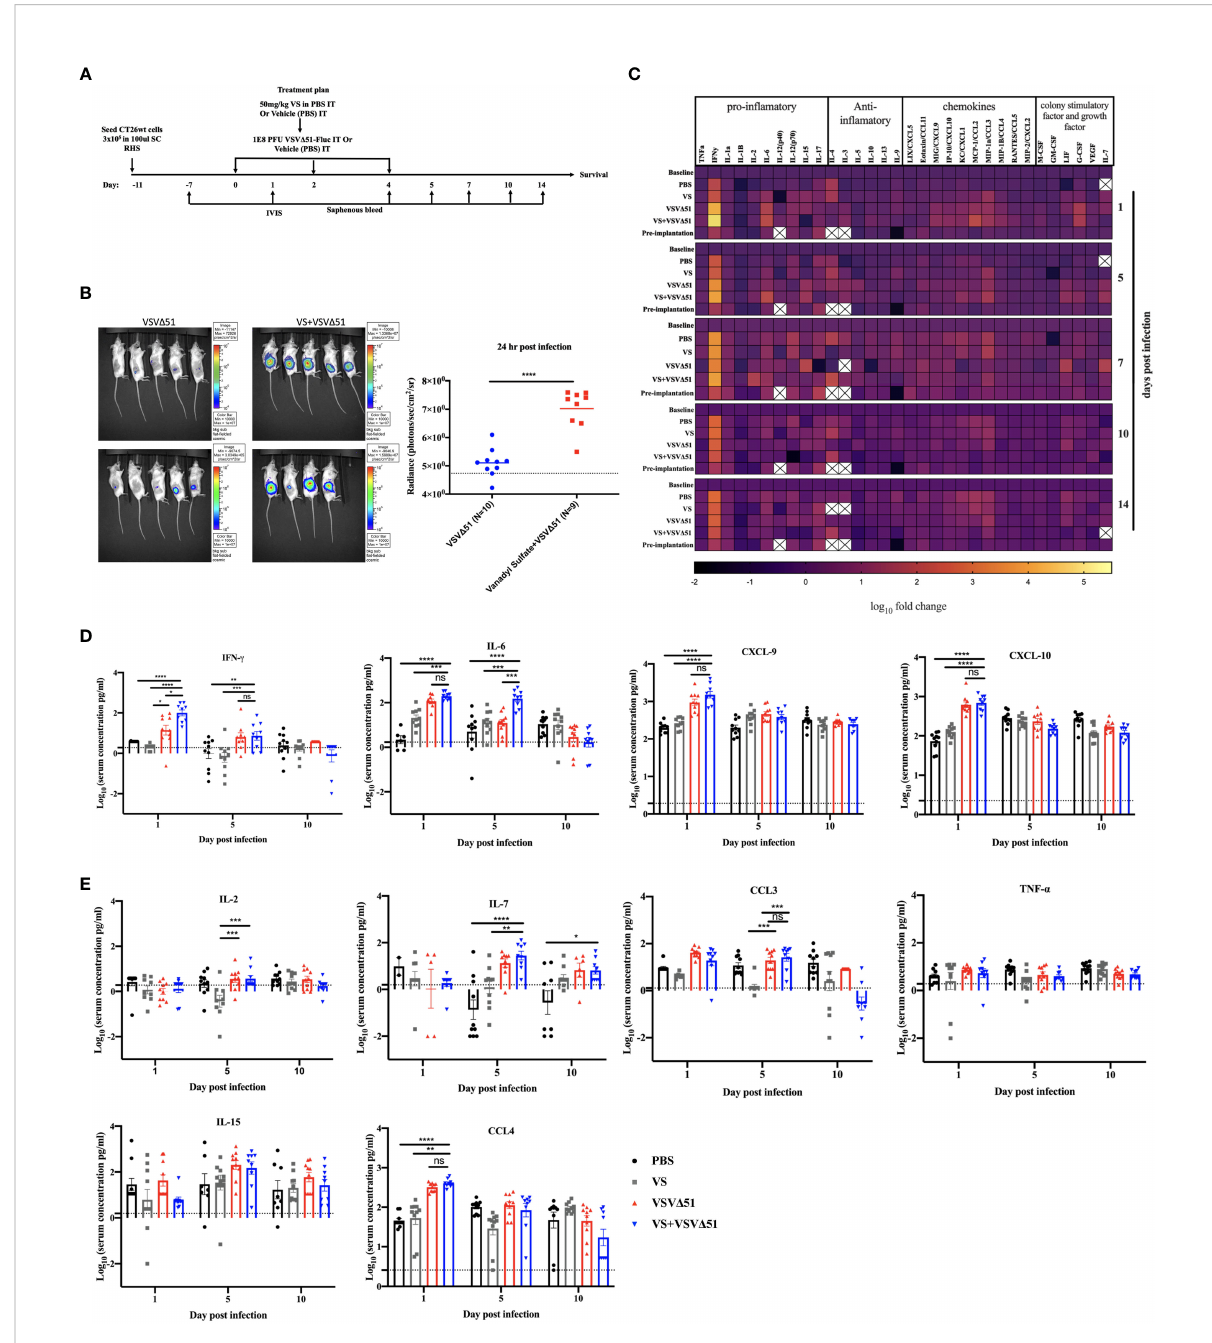
FIGURE 1 VS+VSV D 51 co-treatment upregulates the secretion of pro-in fl ammatory chemokines and cytokines 1 and 5 days post the treatment. (A) Schematic representation of the treatment schedule: CT26WT-tumor bearing mice received a total of three doses delivered intratumorally of vanadyl sulfate (50mg/kg) and VSV D 51- fl uc (1E8 PFU) or monotreatment injections with PBS, vanadyl sulfate (50mg/kg), or VSV D 51- fl uc (1E8 PFU) alone over 5 days. (B) Twenty-four hours post the fi rst treatment, viral replication was monitored by IVIS. Representative bioluminescence images of mice. Scale represented in photons, bar indicate mean. P=0.0007 as compared to mock-treated condition. (C) Heatmap represented the log 10 fold change per condition of pooled sera for all the treated time points, normalized to day 7 post implantation as baseline. (D, E) The concentration of Cytokines and chemokines pg/ml for each group for each individual mouse, data transformed into log 10 . (n=10 per condition), line indicates the detection concentration, Mean ± SEM; * P=0.01, ** P=0.003, *** P=0.001,****P<0.0001, Two-way